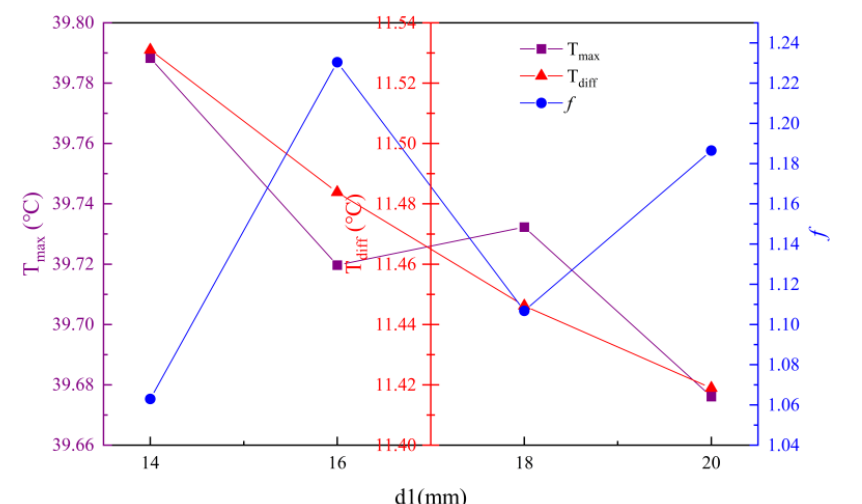
Figure 16. Influence of d 1 on evaluation indexes.